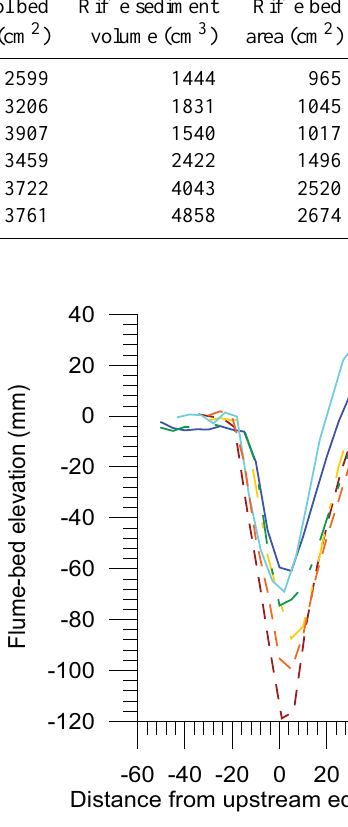
Fig. 3. Longitudinal profiles of flume centerline for pool-riffle se- quences formed by different shaped obstructions to